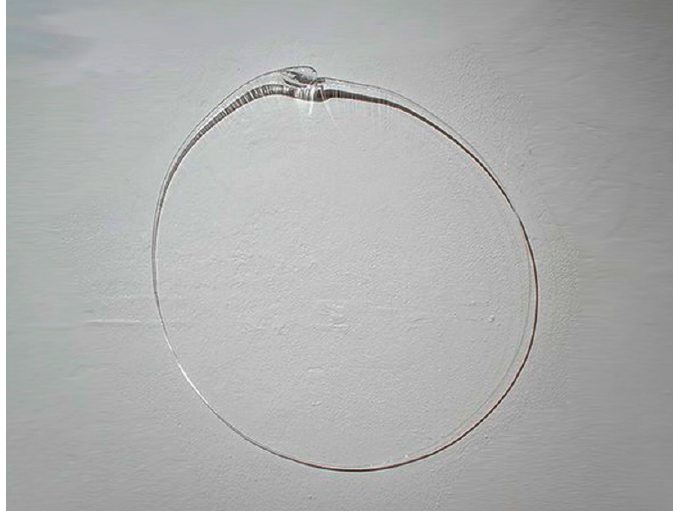
Figure 5. The Glass Circles (2013) by Sunny Wang. Detail.